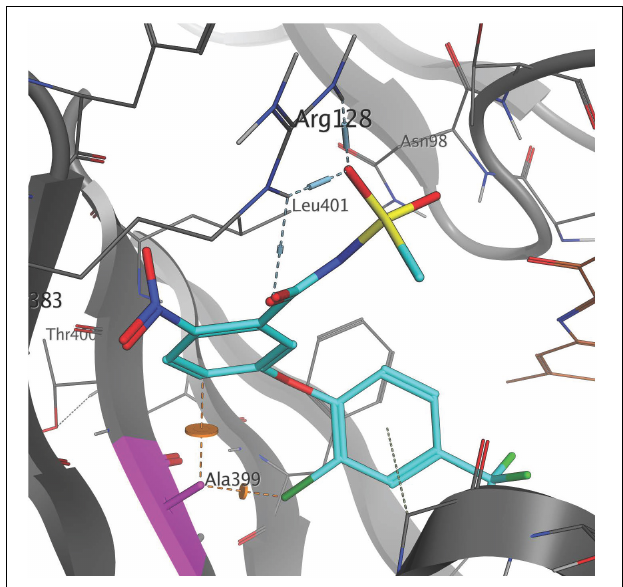
FIGURE 2 | Position of the G399A mutation relative to the predicted binding mode of fomesafen. Fomesafen (cyan) was modeled into the binding-site of a homology model of a PPO2 protein sequence with G399A (gray) mutation. The alanine mutation is shown in pink. The introduction of G399A creates a couple of close steric contacts with the ligand (dashed orange lines and disks). The FAD cofactor (brown) is partially visible to the right. Several amino acid side chains are not shown, to improve clarity. The image was generated with MOE ( Molecular Operating Environment, Chemical Computing Group ULC, Montreal, QC, Canada, H3A 2R7,